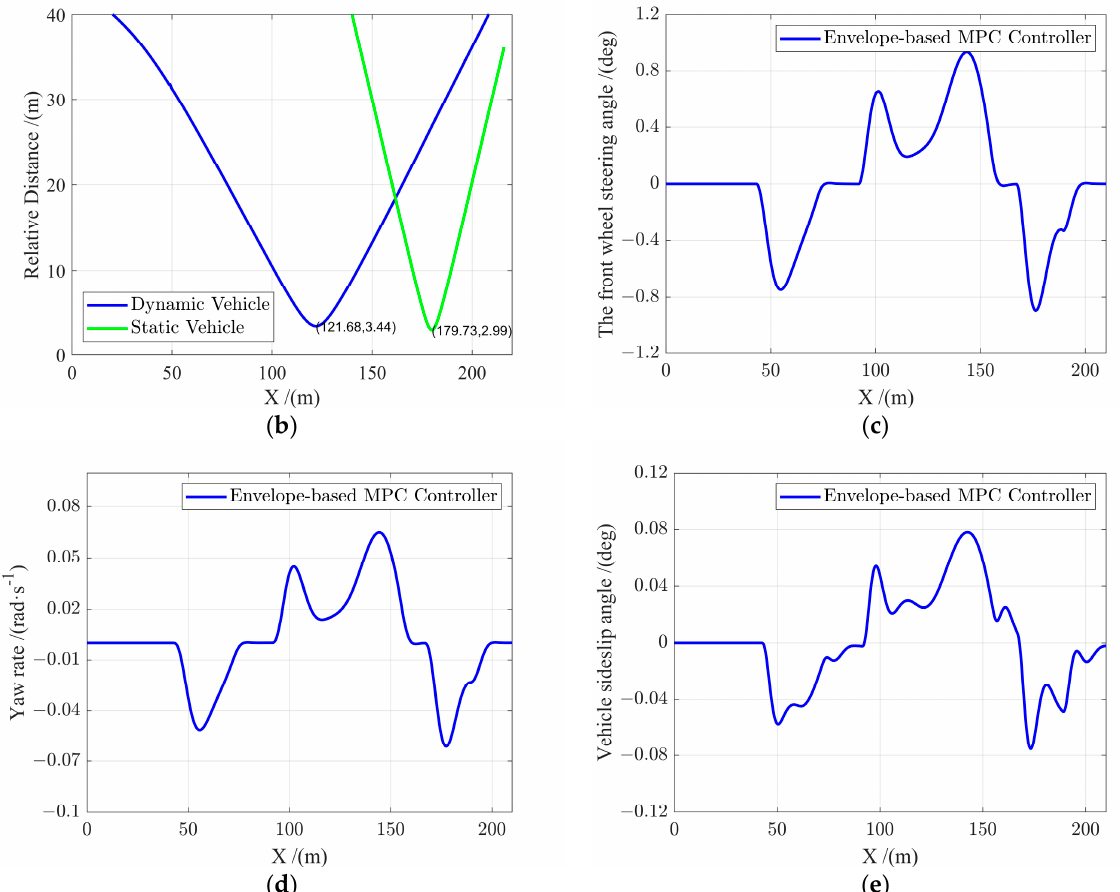
Figure 9. Obstacle avoidance experiment results of scenario B. ( a ) GPR − based obstacle avoidance envelope and the obstacle avoidance trajectory. ( b ) Relative distance. ( c ) The front wheel steering angle. ( d ) Yaw rate ( e ) Vehicle sideslip angle.